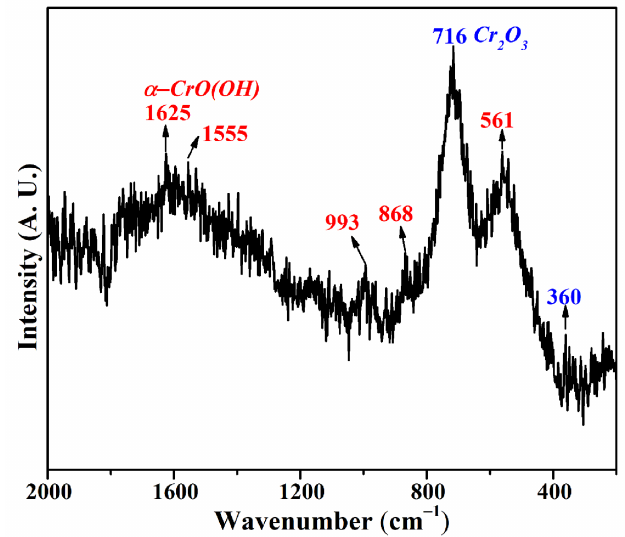
Figure 5. Raman spectrum of